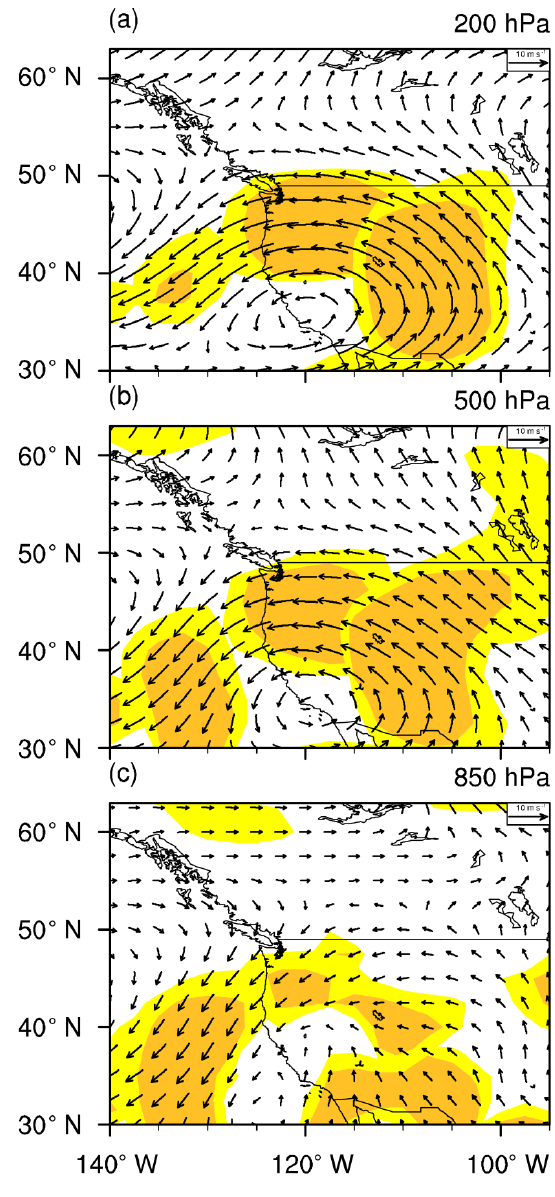
Figure 4. Differences in composite April winds (vectors, ms − 1 ; from NCEP-2) between positive and negative ASO anomaly events at 200hPa (a) , 500hPa (b) and 850hPa (c) for 1984–2016. Colored regions are statistically significant at the 90% (light yellow) and 95% (dark yellow) confidence levels. The seasonal cycle and linear trend were removed from the original dataset. The ASO anomaly events are selected based on Table